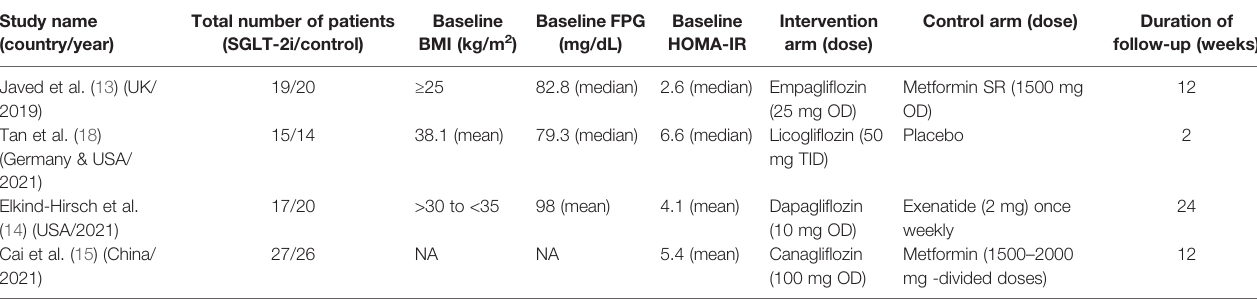
TABLE 1 | Baseline characteristics of the